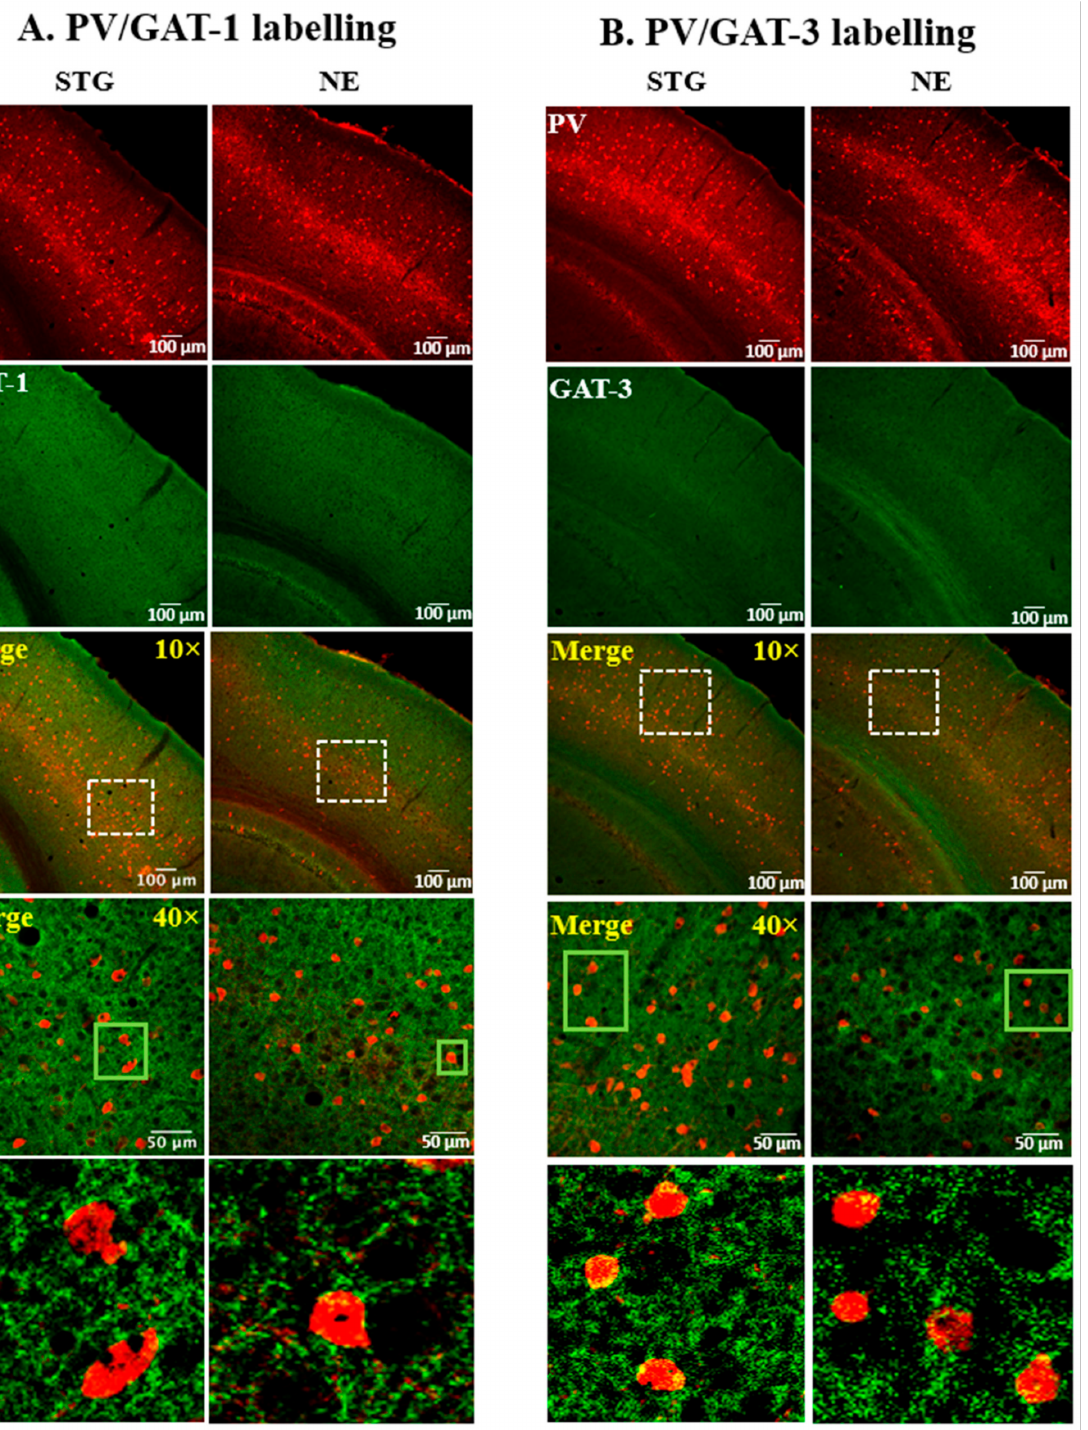
Figure 2. Representative confocal images showing the expression of ( A ) GAT-1 or ( B ) GAT-3 and PV in the SScortex of epileptic stargazers (STG) and non-epileptic littermates (NE). Merged images at low magnification (10 × ) and medium magnification (40 × ) are shown. White dotted boxes in the third panel were magnified in the fourth panel. Green boxes in the fourth panel were magnified in the bottom panels of figures ( A , B ) to show punctate